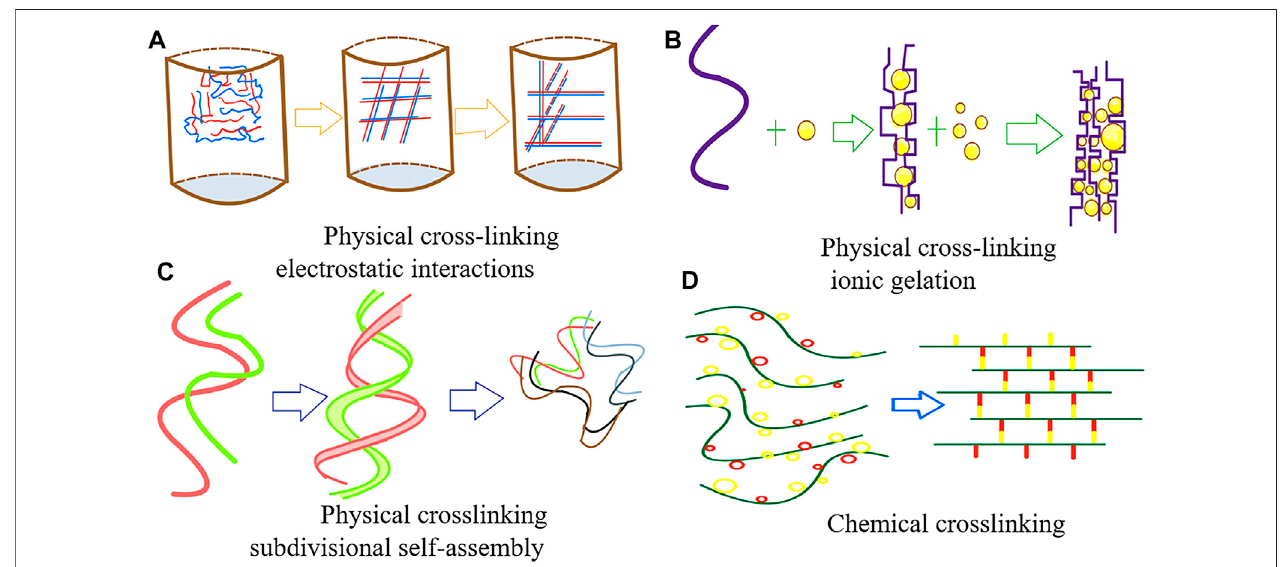
FIGURE 1 | Cross-linking methods for